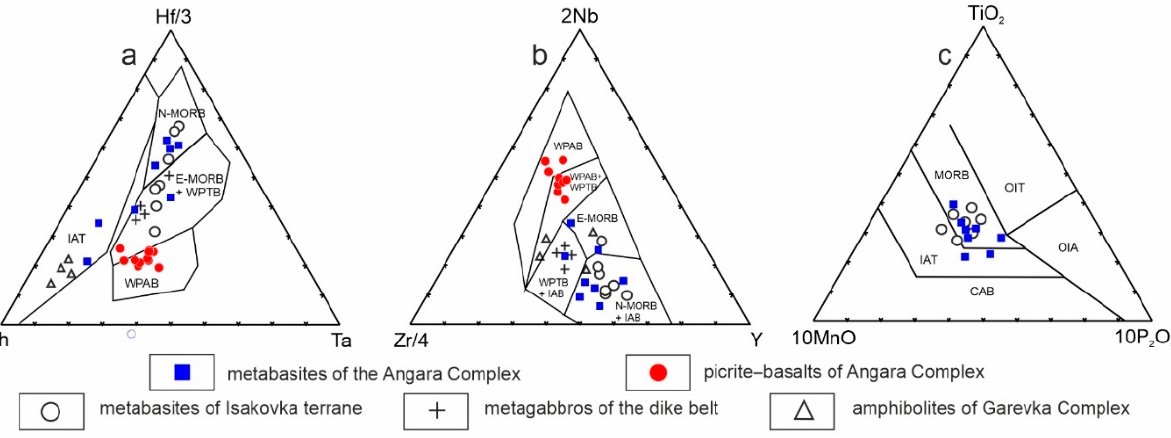
Figure 33. Plots ( a ) Hf–Th–Ta, ( b ) Zr–Nb–Y, and ( c ) TiO 2 -MnO-P 2 O 5 for metabasite compositions of